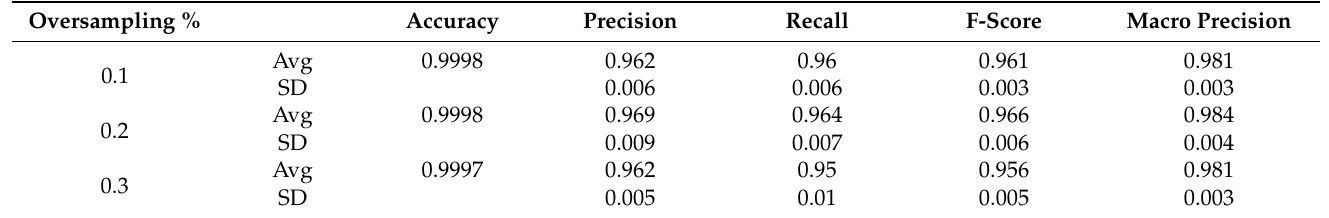
for Backdoors (UNSW-NB15) for the various oversampling percentages (0.1 to 1.0, at intervals of 0.1). The best results are highlighted in green. Table 9. UNSW-NB15: Backdoors—classification results for random undersampling before splitting. Oversampling